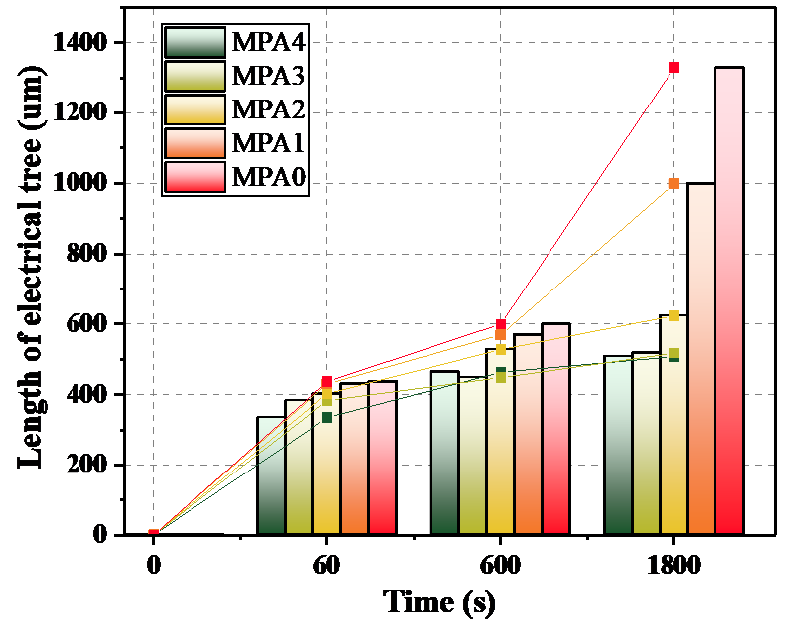
Figure 6. Relationship between the growth lengths of electrical trees and time for each MPA ratio.